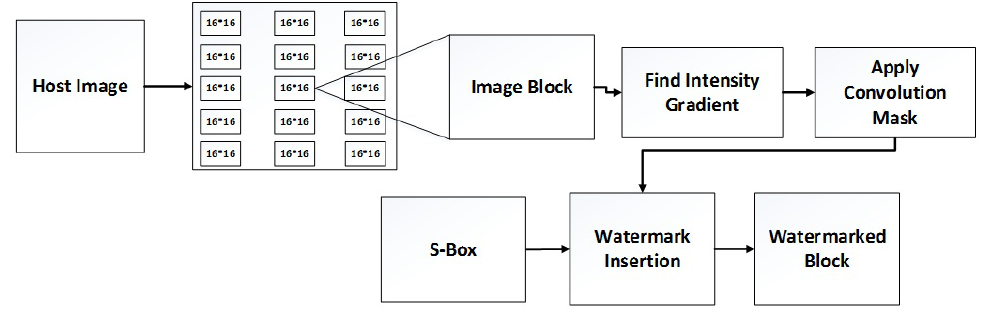
Figure 3. Watermark embedding flow